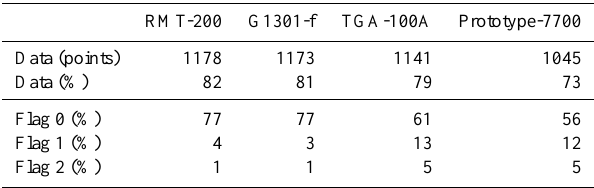
Table 2. Amount of data obtained between 17 April and 17 May is given in the first two rows and in the three next rows the data is divided into bins according to data quality. Maximum number of data points during this period is 1440. Data with flag 0 include those periods when flux stationarity test Foken and Wichura (1996) was smaller than 0.3. Flag 1 corresponds to those periods when station- arity test was between 0.3 and 1 and flag 2 corresponds to station- arity test with value larger than